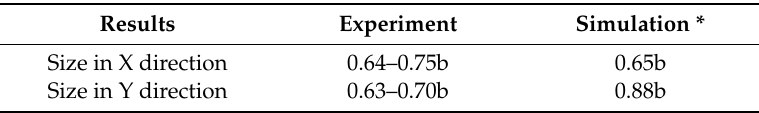
Table 2. The sizes of the damage